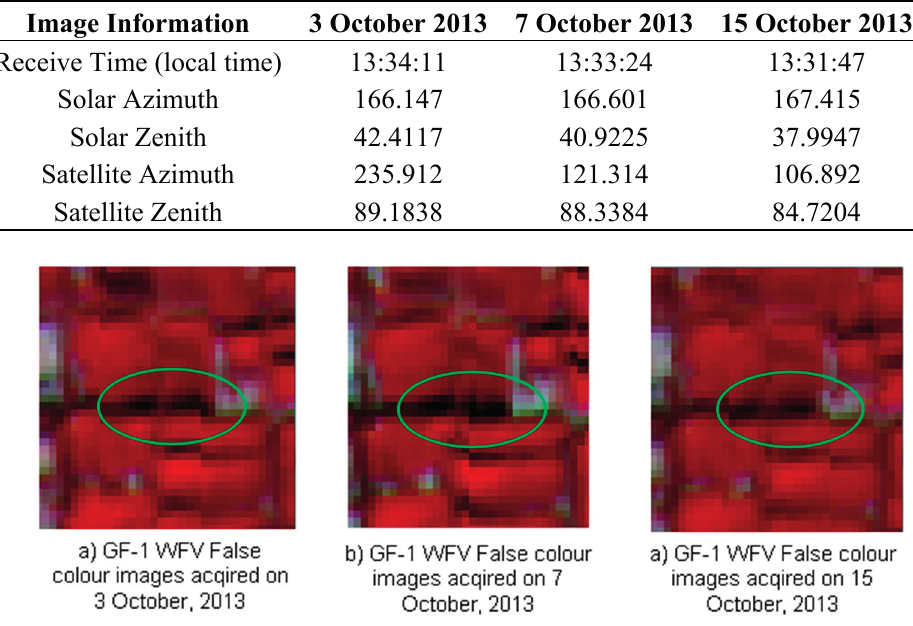
Figure4. An example of the difference in shadow direction and